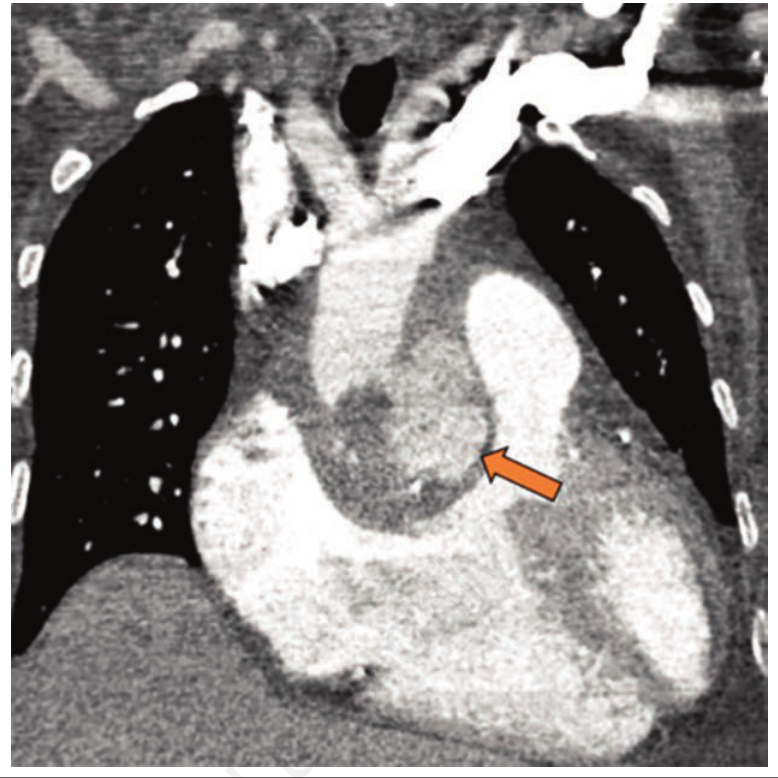
Figure 1. CTA chest demonstrating a pseudoaneurysm of the ascending aorta (arrow) with intravascular thrombus formation.